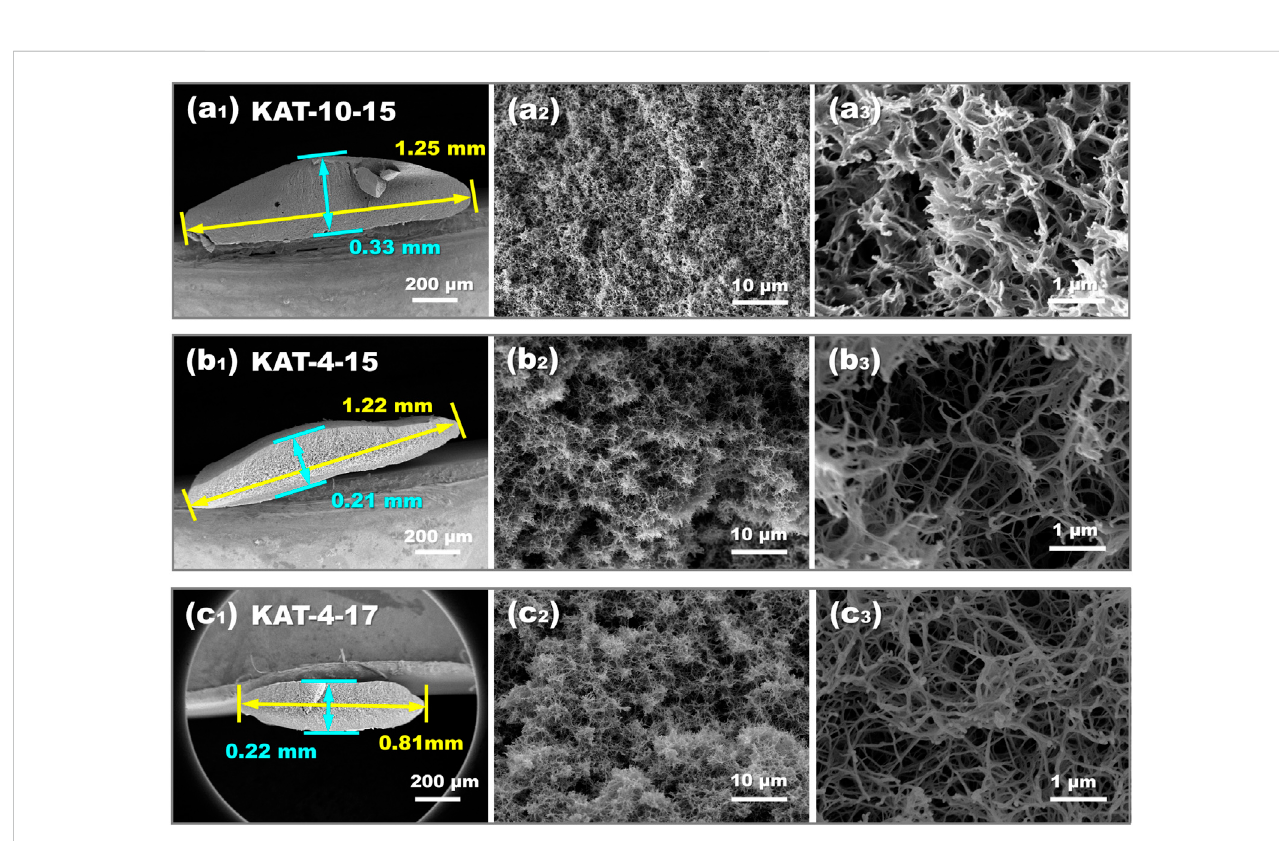
FIGURE 3 The size and microstructure of several representative Kevlar aerogel tapes observed by SEM: (A) KAT-10 – 15, (B) KAT-4 – 15, and (C) KAT-4 – 17.